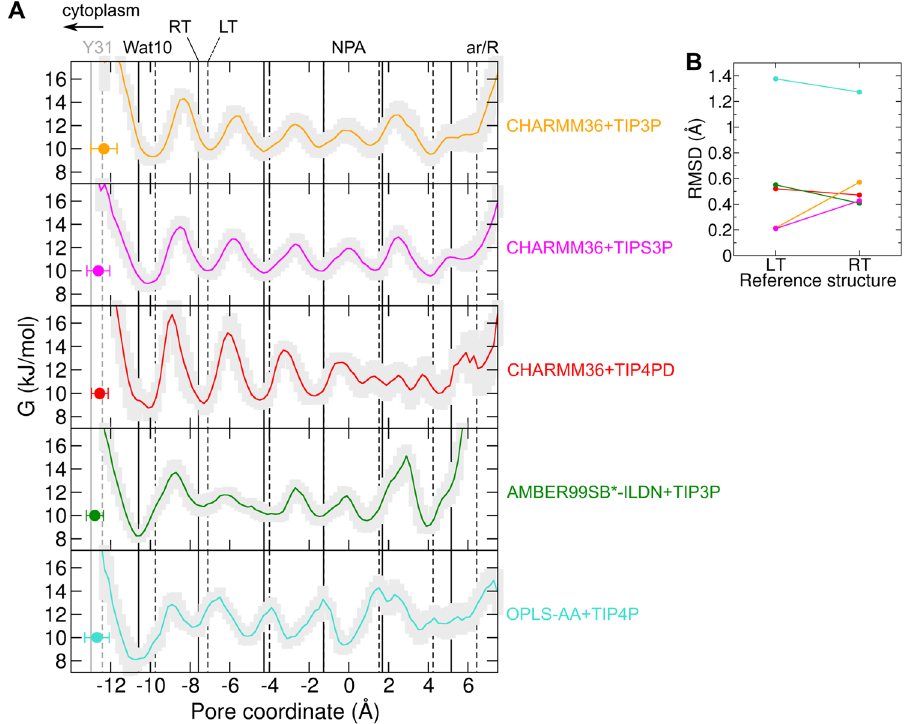
Figure 5. Positions of the gating residue Tyr31 and the water molecules inside the pore. ( A ) Potential of mean force (PMF) for the water permeation along the pore coordinate extracted from equilibrium MD simulations for the indicated force-fields (average: colored line, uncertainty: light gray shadow). The PMF minima indicate the most preferred positions of the water molecules throughout the simulations. Vertical lines represent the crystallographic positions in the RT structure (solid lines) and in the LT structure (dashed lines). Crystallographic positions of water molecules (including Wat10) are displayed in black and crystallographic position of the Tyr31 OH atom in gray. Tyr31 was found displaced towards the cytoplasm by about 0.5 Å at room temperature compared to low temperature. The two water molecules nearest Tyr31 also displaced towards the cytoplasm at room-temperature by about 0.5 and 0.8 Å, respectively. The latter displacement corresponds to Wat10. Average position ( ± standard deviation) along the pore coordinate of the Tyr31 OH atom recovered from the simulations is presented for comparison (colored dots). ( B ) Root mean square deviation (RMSD) of the PMF minima (most-favored water positions) with respect to the RT and LT crystallographic water positions is presented (same color-coding as in A